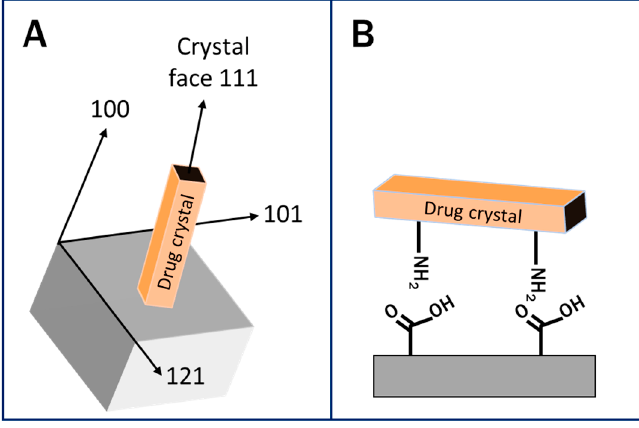
Figure 4. Parameters affecting heterogeneous crystallization: ( A ). Lattice matching and ( B ). Surface Figure4. Parametersaffectingheterogeneouscrystallization: ( A )Latticematchingand( B chemistry.